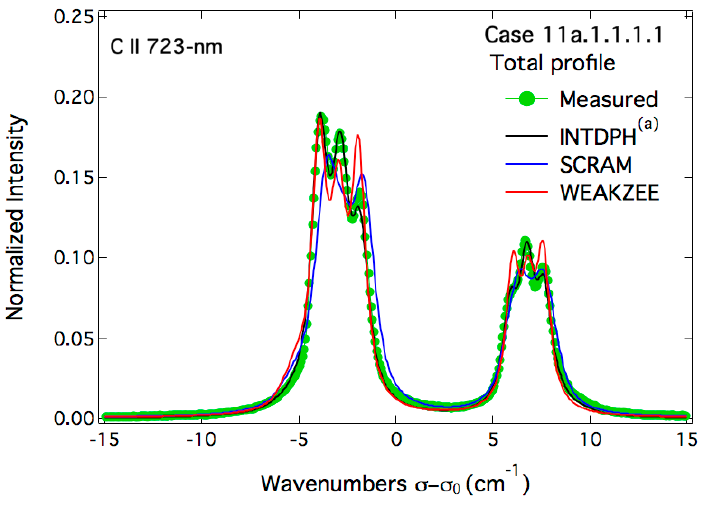
Figure 11. Fitting attempts of the un-polarized “experimental” spectrum of the C II 723-nm line as constructed from σ - and π -polarized spectra of Figures 9 and 10. Superscript (a) indicates that the area of the profile calculated with INTDPH is equal to 0.9 while all other spectra are normalized to